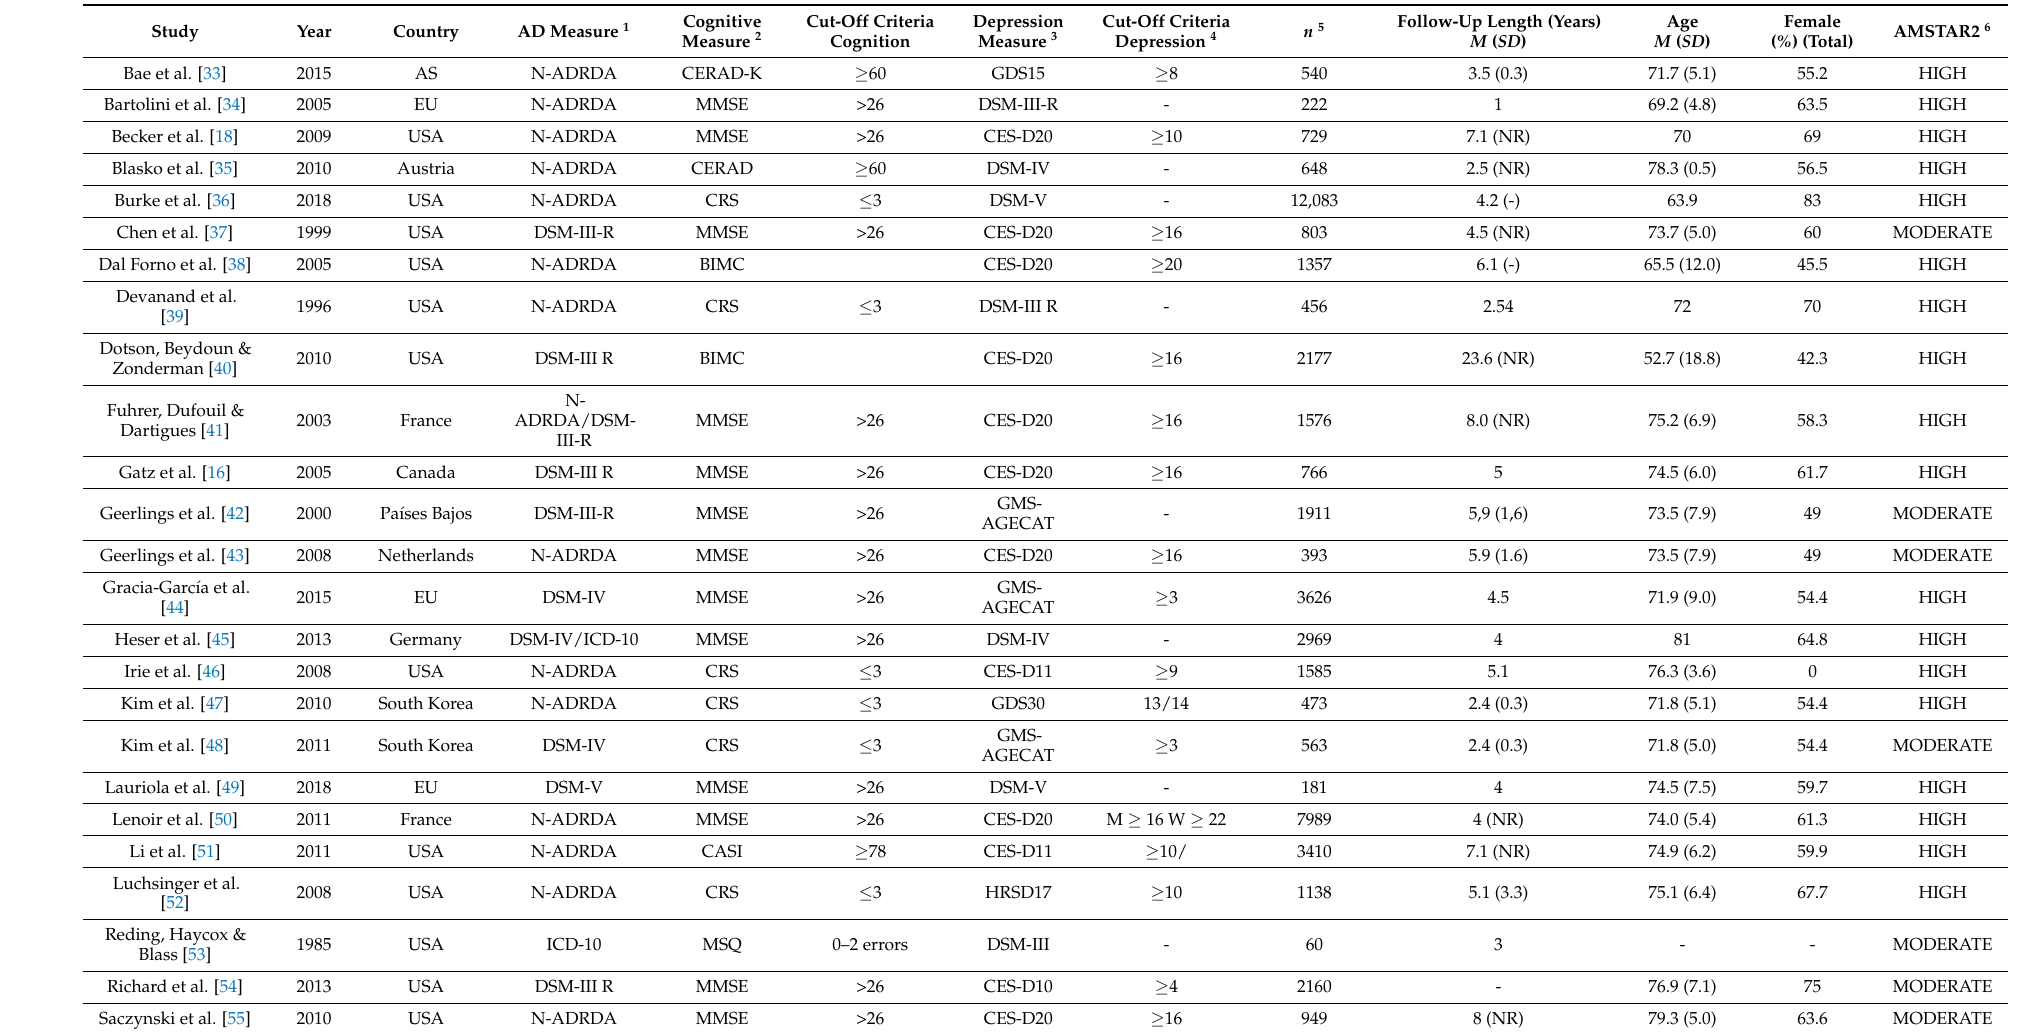
Table 1. Summary of demographic and study